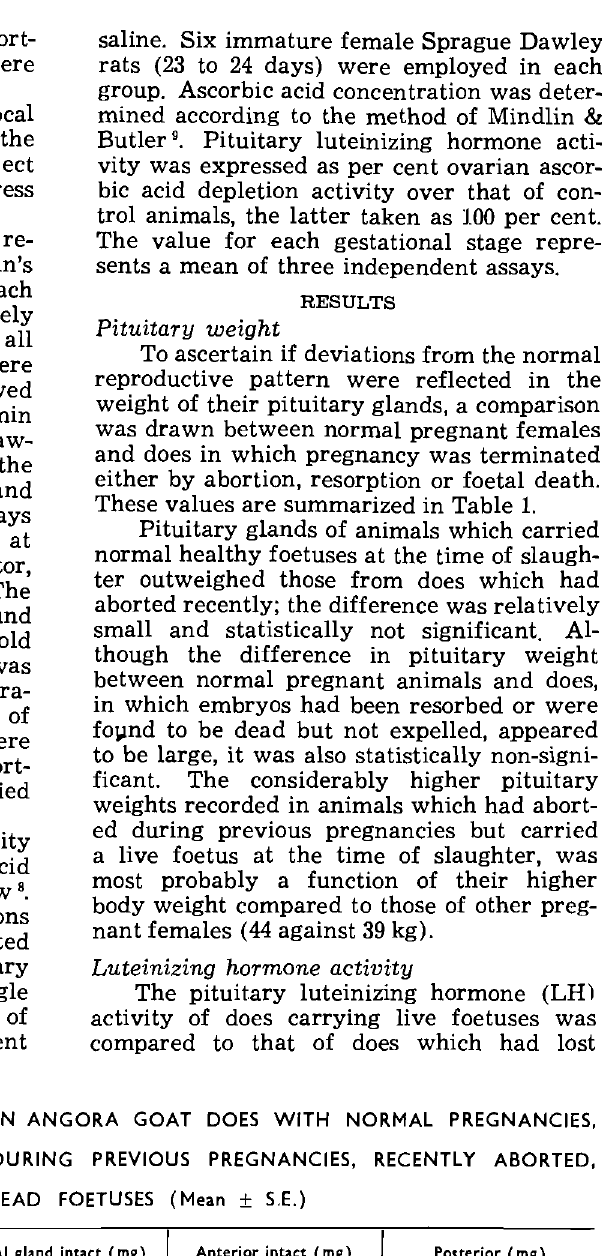
Table 1: WEIGHT OF THE PITUITARY GLAND IN ANGORA GOAT DOES WITH NORMAL PREGNANCIES, NORMAL PREGNANCIES BUT ABORTION DURING PREVIOUS PREGNANCIES, RECENTLY